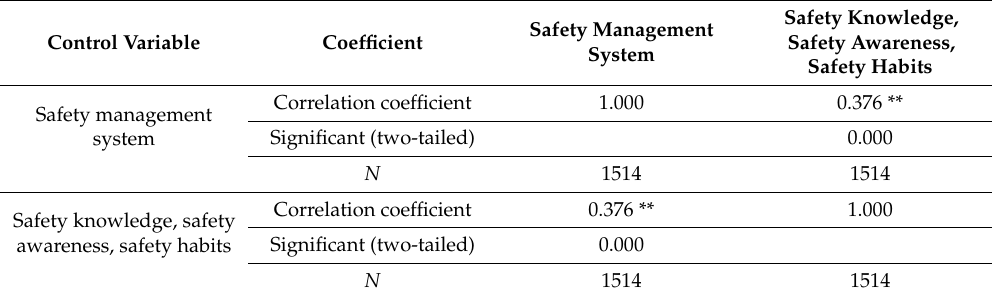
Table 4. Correlation coefficient between safety management system and safety knowledge, safety awareness and safety habits.